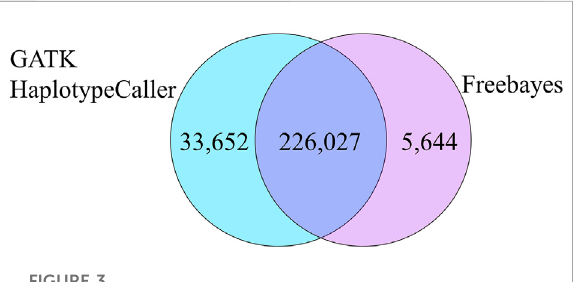
FIGURE 3 Total non-concordant SNPs that were common and unique between the two variant callers compared to the bead